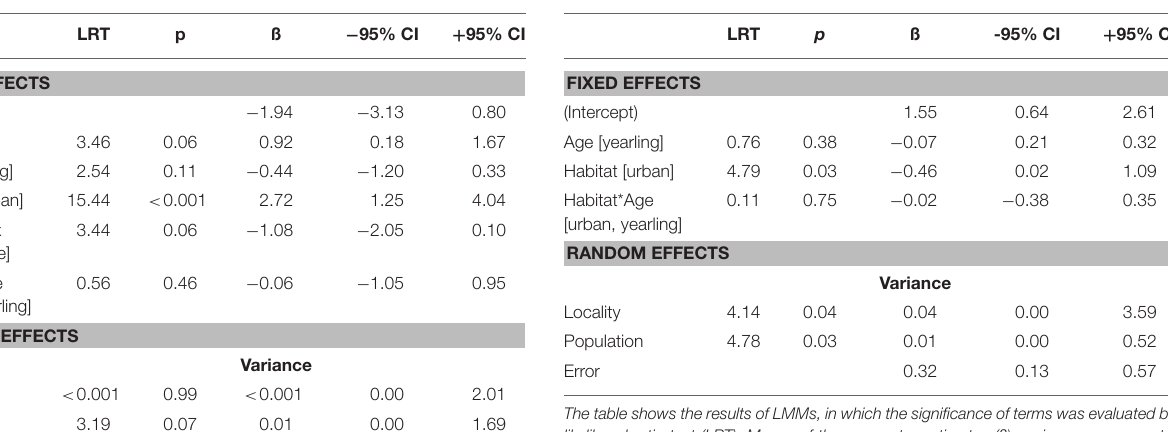
TABLE 5 | Statistical summary of the analysis of pecking rate for male great tits between rural and urban habitats.